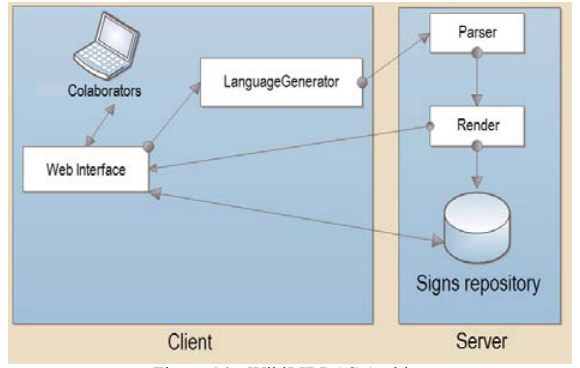
Figura 14 - WikiLIBRAS Architecture